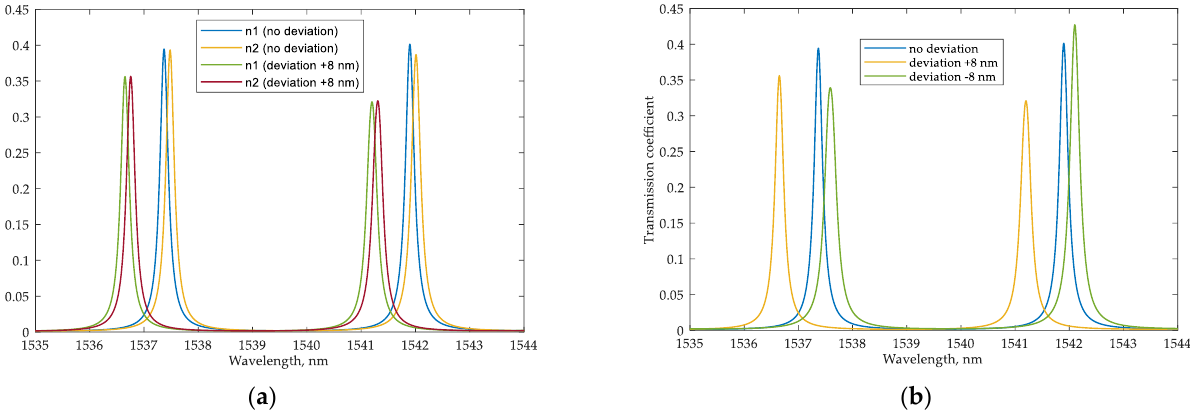
Figure 20. ( a ) Sensor’s transmission spectra for sensing an RI increment of 0.001 (n1 = 1.311, n2 = 1.312) in the case of fabrication deviation of the waveguide width of +8 nm; ( b ) sensor’s transmission spectra for the same analyte RI (n = 1.311) for the fabrication deviation of the waveguide width of ±8 nm.